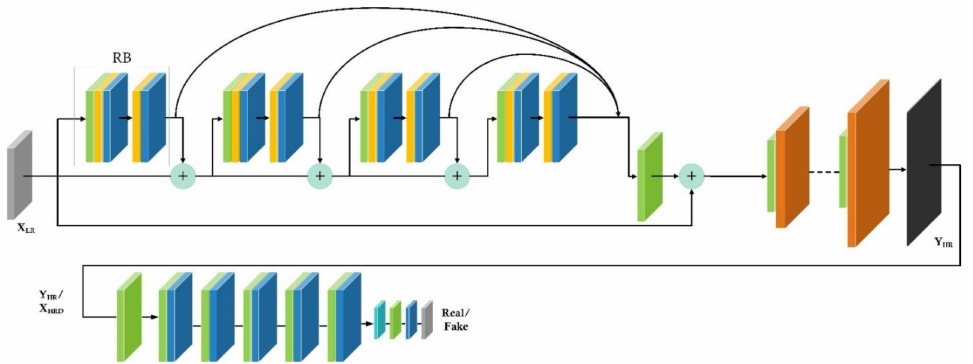
Figure 6. SR-GAN with an EDSR-RFA generator at the top with the discriminator at the bottom. The layers include convolution (RFA block) ( green ), normalization (RFA block) ( yellow ), ReLU activation (RFA Block) ( blue ), a 1 × 1 reduction layer ( light blue ), and a pixel rearrangement layer ( brown ). Output Y HR of the generator is the input X HRD to the